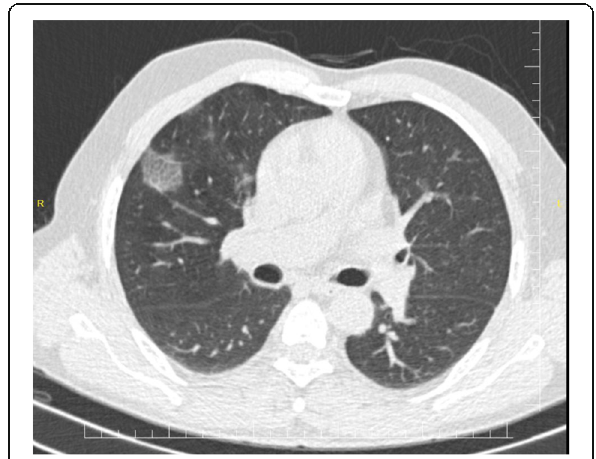
Fig. 2 An axial chest CT from a 50-year-old man with COV İ D-19 pneumonia. Non-contrast-enhanced chest CT image showed focal ground-glass opacity associated with smooth interlobular and intralobular septal thickening in the right upper lobe. The left lung was normal